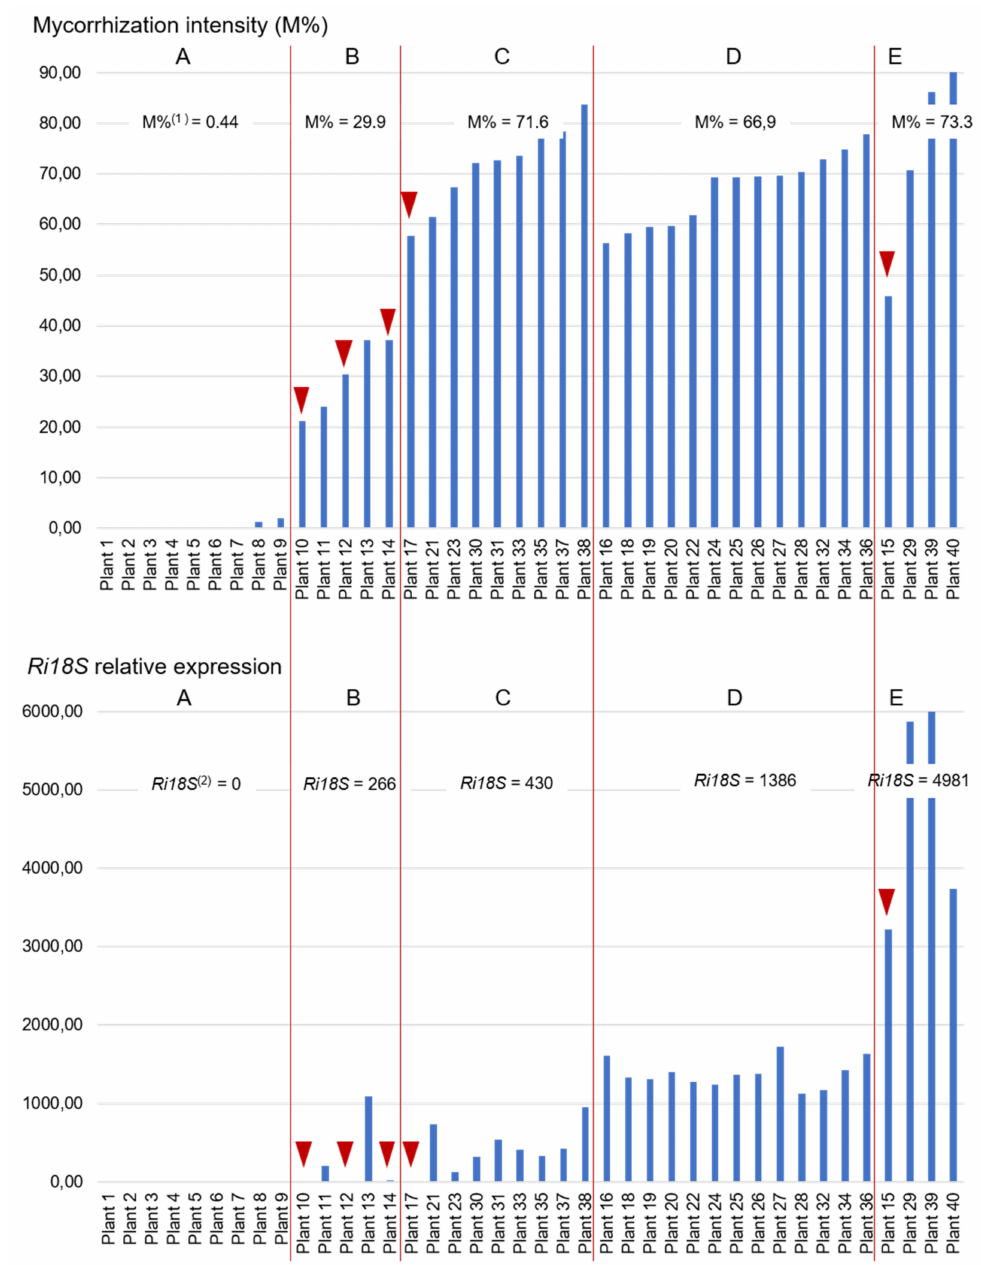
Figure 1. Mycorrhization intensity and relative expression of Ri18S gene in 40 grapevine plants. A, B, C, D, E: clusters obtained by Ascending Hierarchical Classification (AHC) on AMF-inoculated plants according to their mycorrhization intensity and Ri18S expression; red triangles point to outstanding plants. (1) : mean of mycorrhization intensity of the cluster. (2) : mean of Ri18S gene relative expression of the